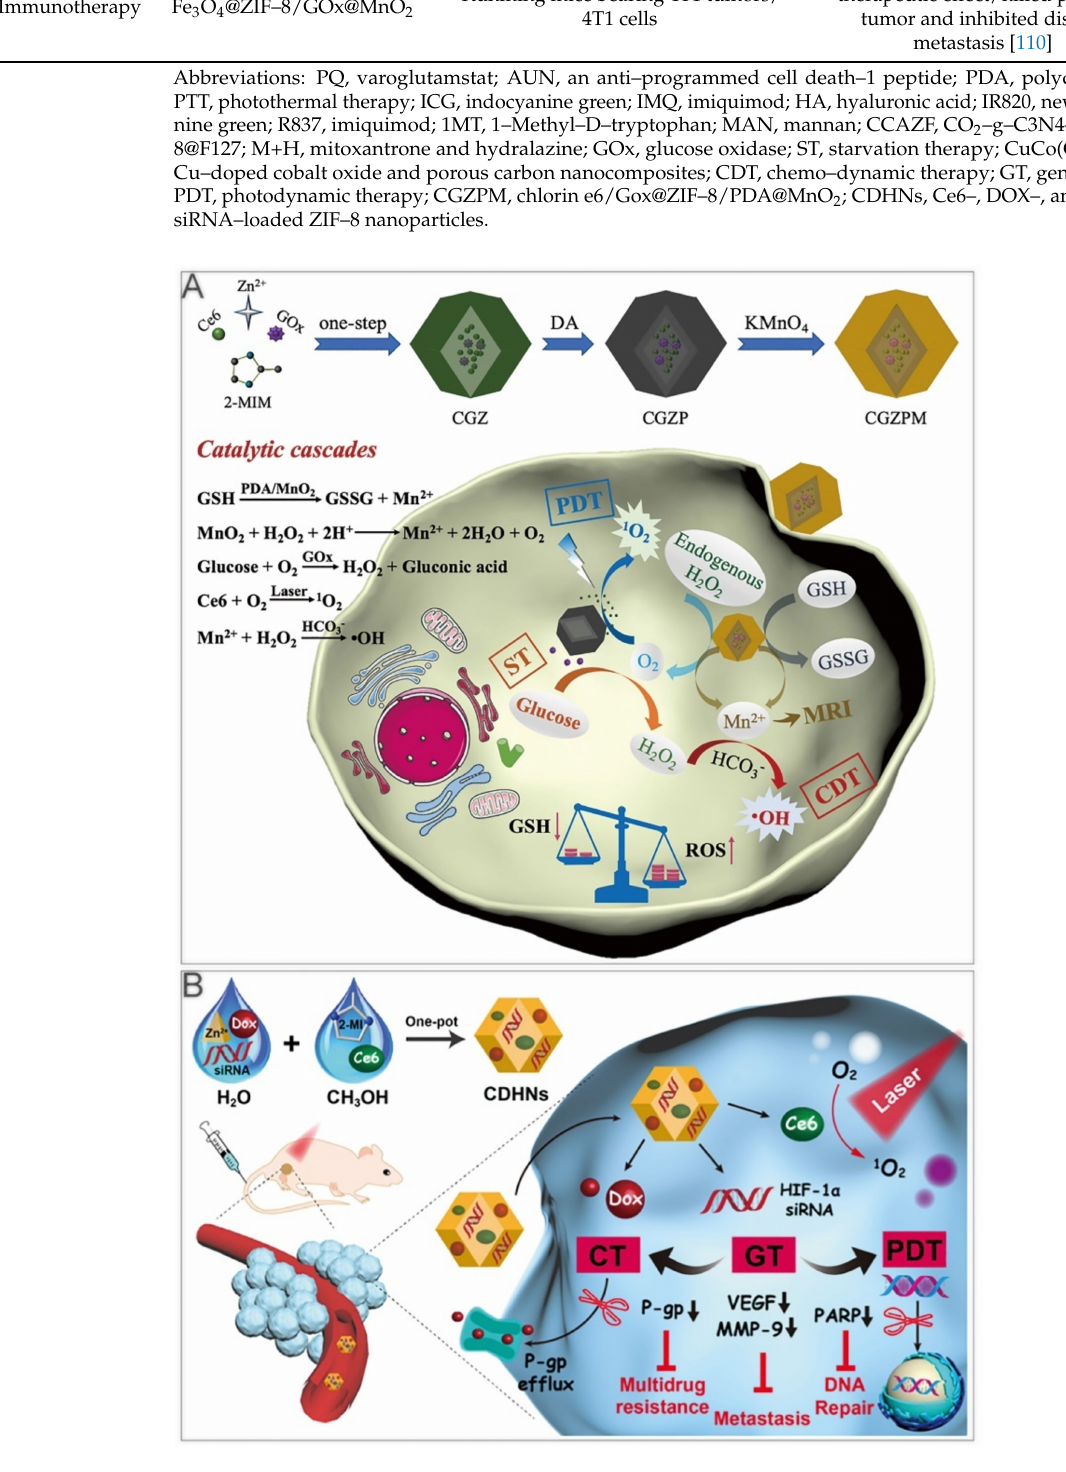
Figure 7. ZIF–8 nanoplatforms for triple cancer therapy. ( A ) ZIF–8 nanoplatforms for